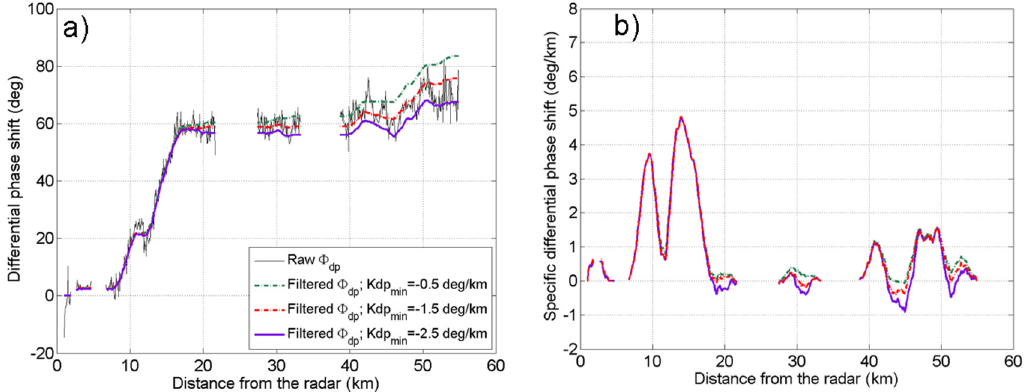
Figure A3. Example of differential phase shift ( φ dp ) and estimated K dp on 14 October 2015 taken at 6.2 deg elevation angle and 107 deg azimuth. ( a ) Raw φ dp (black line) and four φ dp filtered versions (colored lines) using several K dp minimum thresholds ( K dp_ min ) as specified in the panel’s legend; ( b ) Estimates of K dp for the values of K dp_ min specified in the panel’s legend.